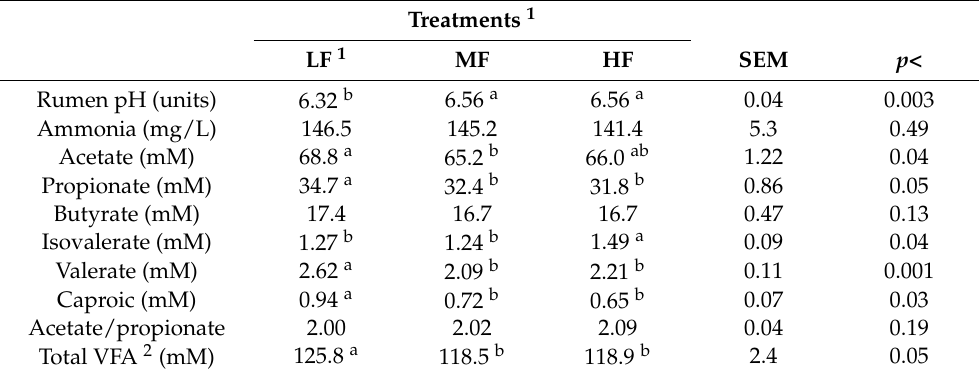
Table 4. Least squares means of rumen pH and concentrations of ammonia and volatile fatty acids (VFA).